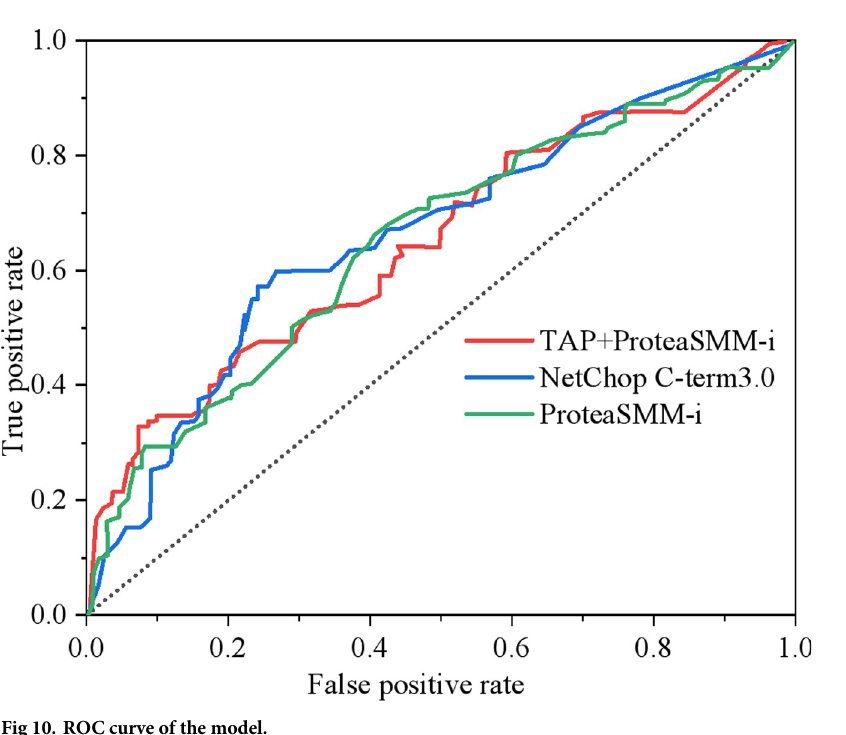
Fig 10. ROC curve of the